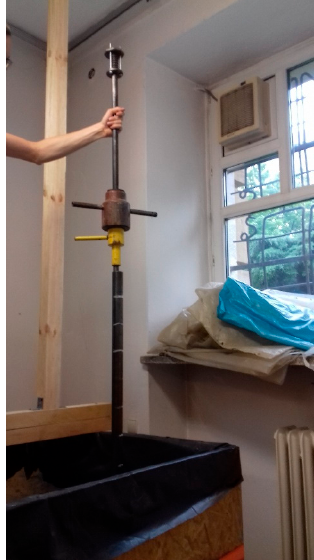
Figure 5. Pile installation with a light dynamic penetrometer. Appl. Sci. 2020 , 10 , x FOR PEER REVIEW